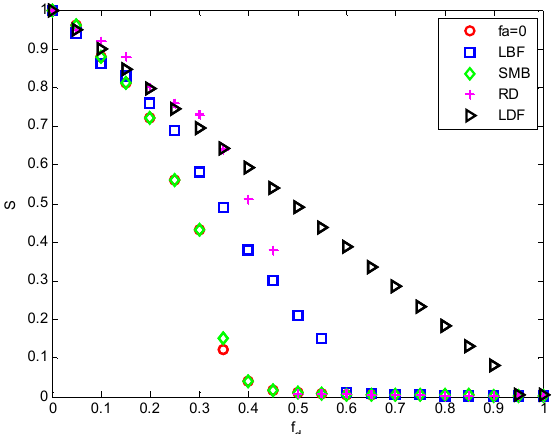
Figure 9. Invulnerability variation diagram of each edge-increasing strategy. Table 6. Simulation data of different edge-increasing strategies.